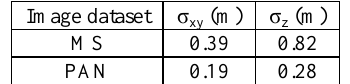
Table 1. Aerotriangulation results: Overall standard deviation of the aerotriangulations.